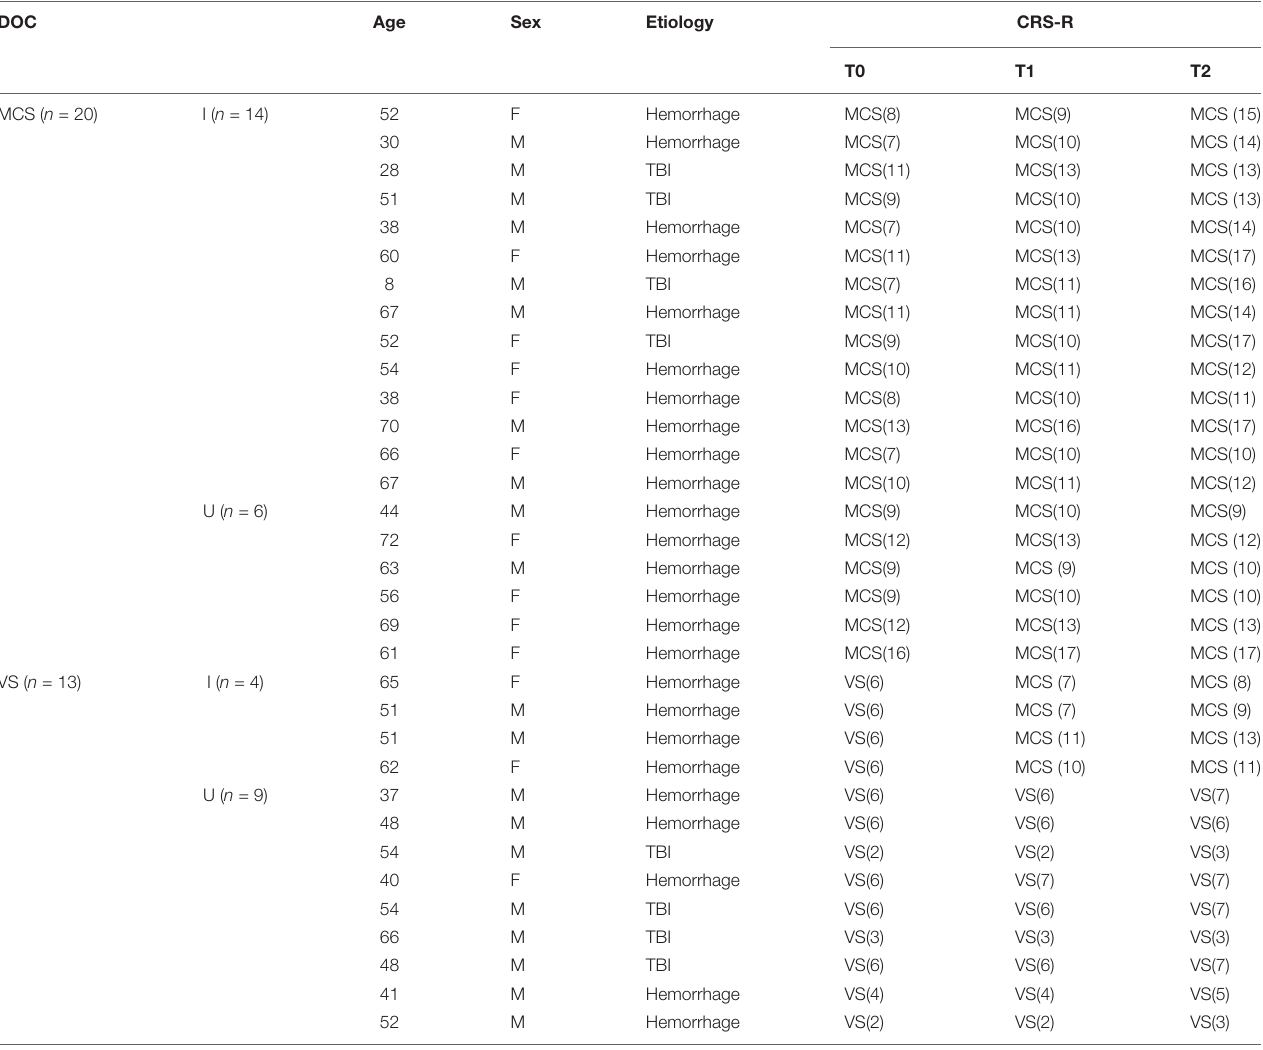
TABLE 1 | Demographicand clinical data of the included